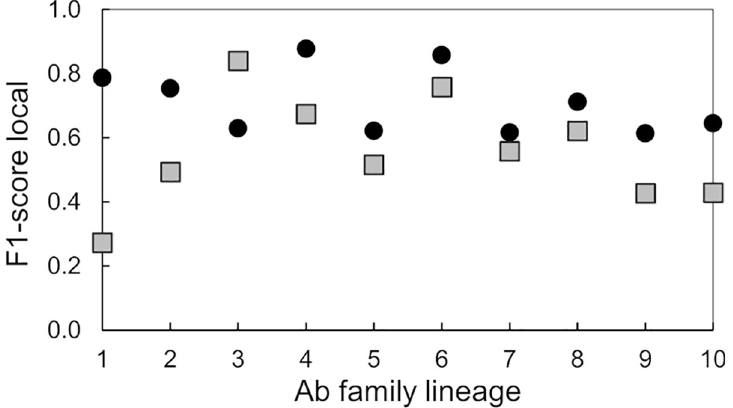
Fig 5. Prediction accuracy of DNNs trained to detect Ab family lineage. Plot of the “F1-score local”-metric as a function of the family lineage for two types of DNN models that we trained with Ab fingerprints generated by two alternative coloring schemes, i.e., by residue charge (black circles) or by reduced-amino-acid alphabet (grey squares).